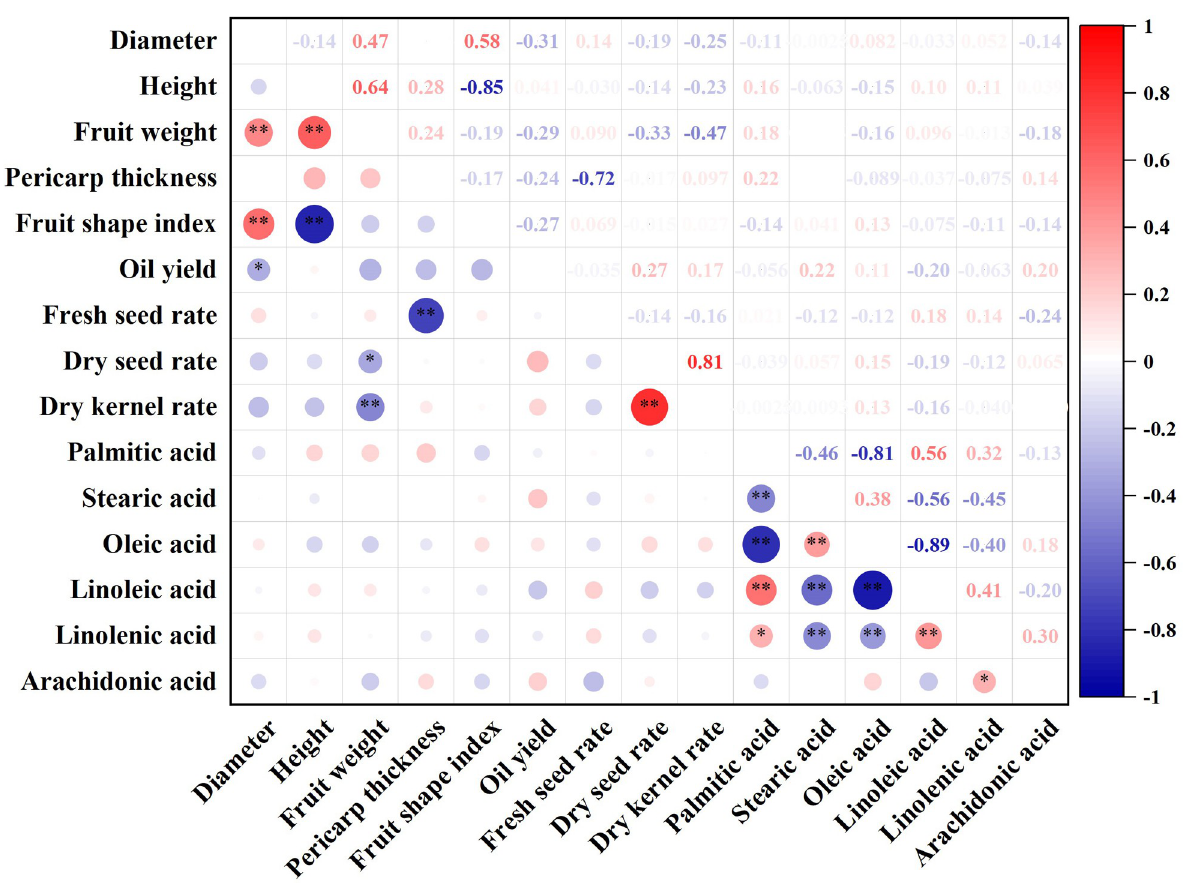
Fig 2. Correlation analysis of the characters of C . weiningensis using origin. Notes: � significantly correlated (P < 0.05); �� very significantly correlated (P < 0.01).